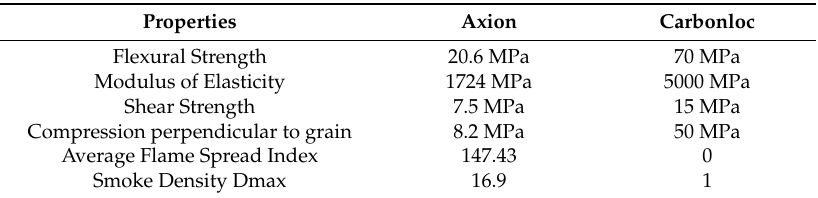
Table 4. Comparative properties of composite materials